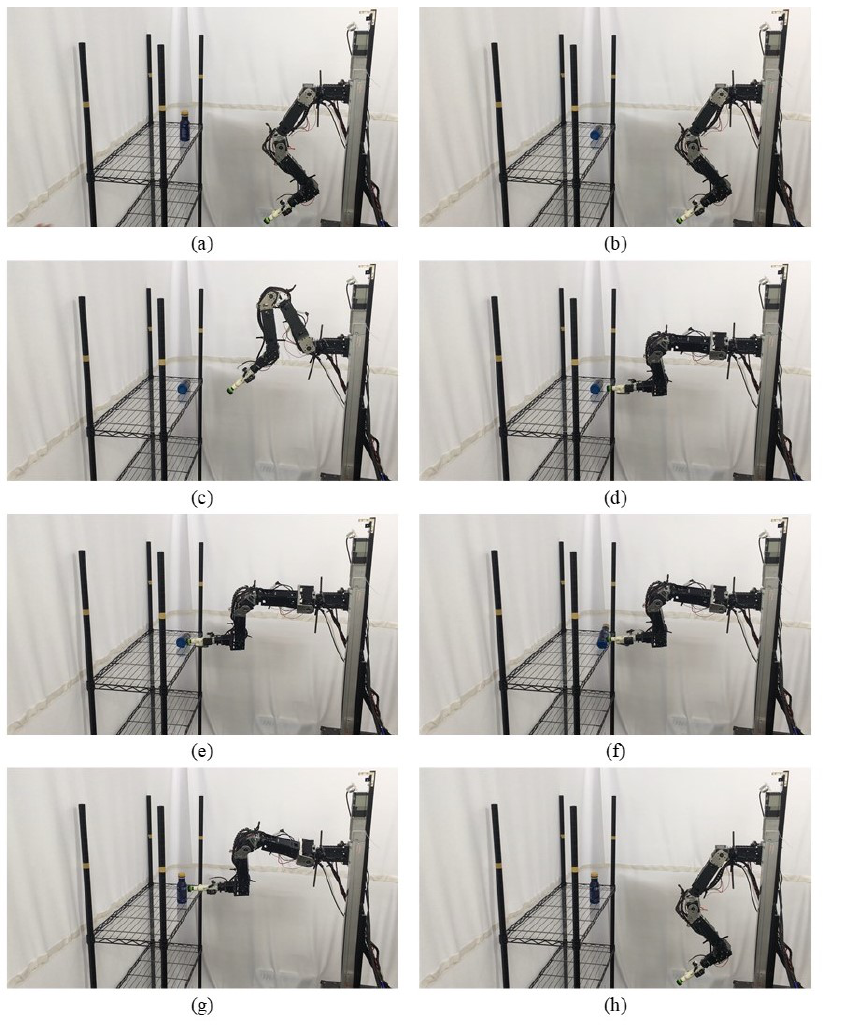
Figure 13. Experimental snapshots of the experiment of the proposed manipulation planning for the object re-orientation. Table 5. Average processing time in each step of the proposed 3D keypoint detection